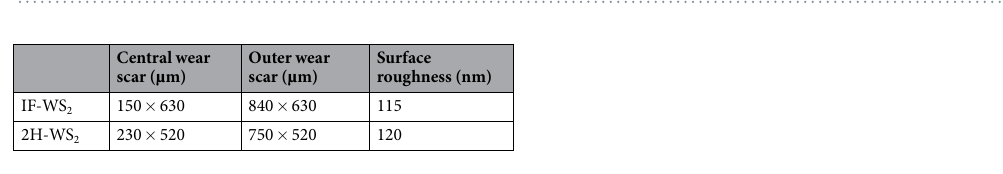
Table 6. S:W ratio on the wear tracks of the 2H and IF-WS 2 composites.